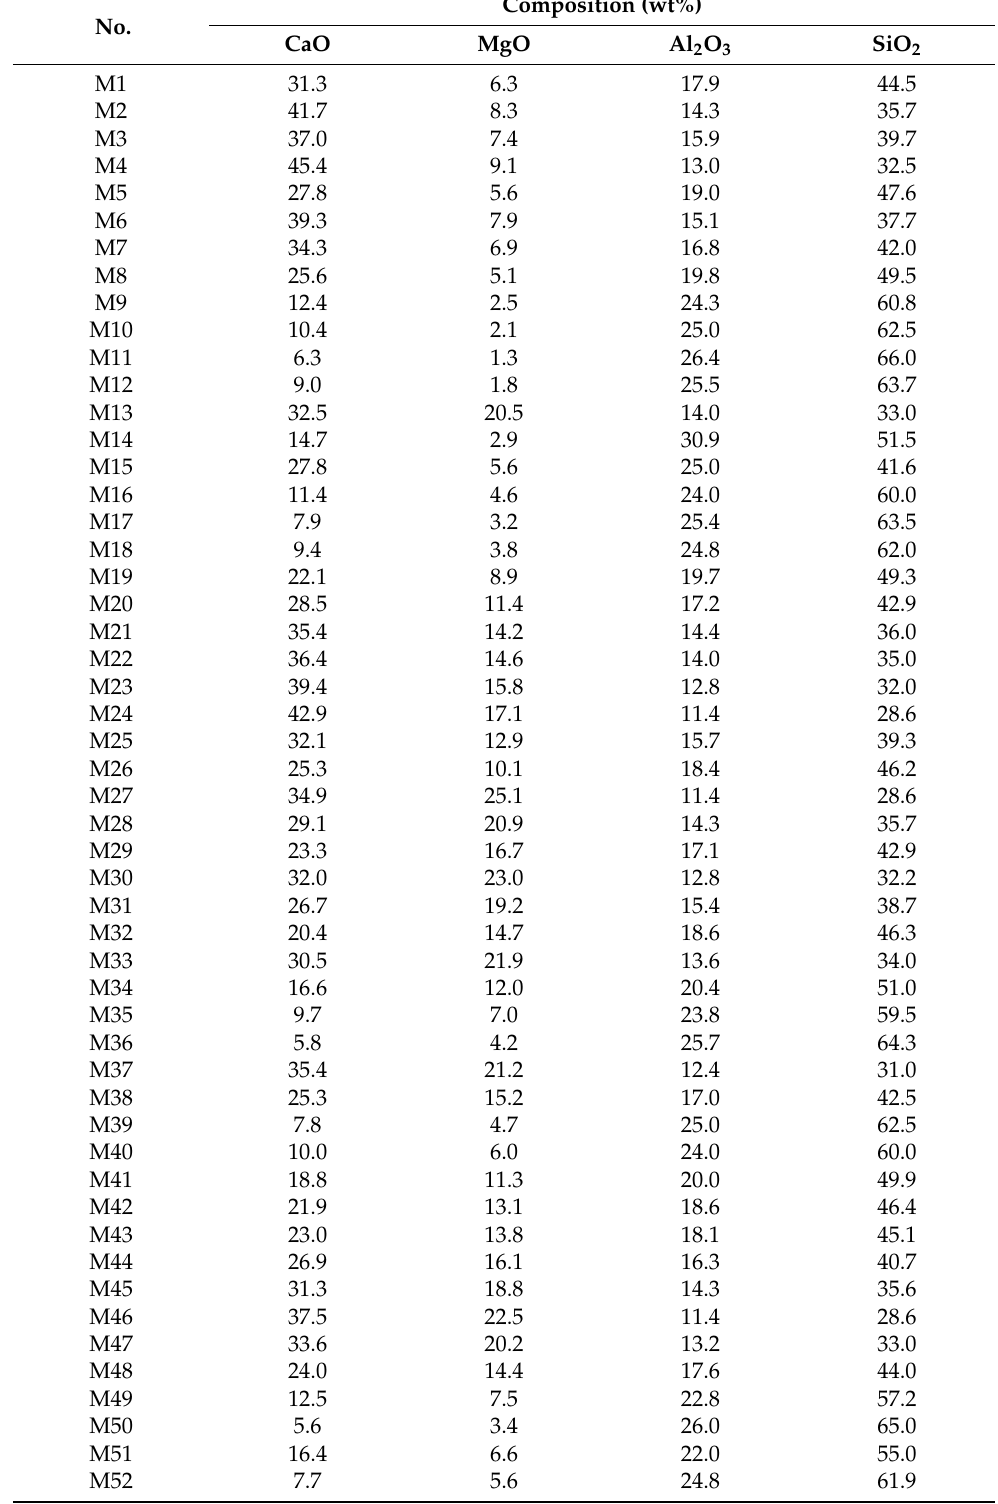
Table A1. Initial compositions of the sample used in the high temperature